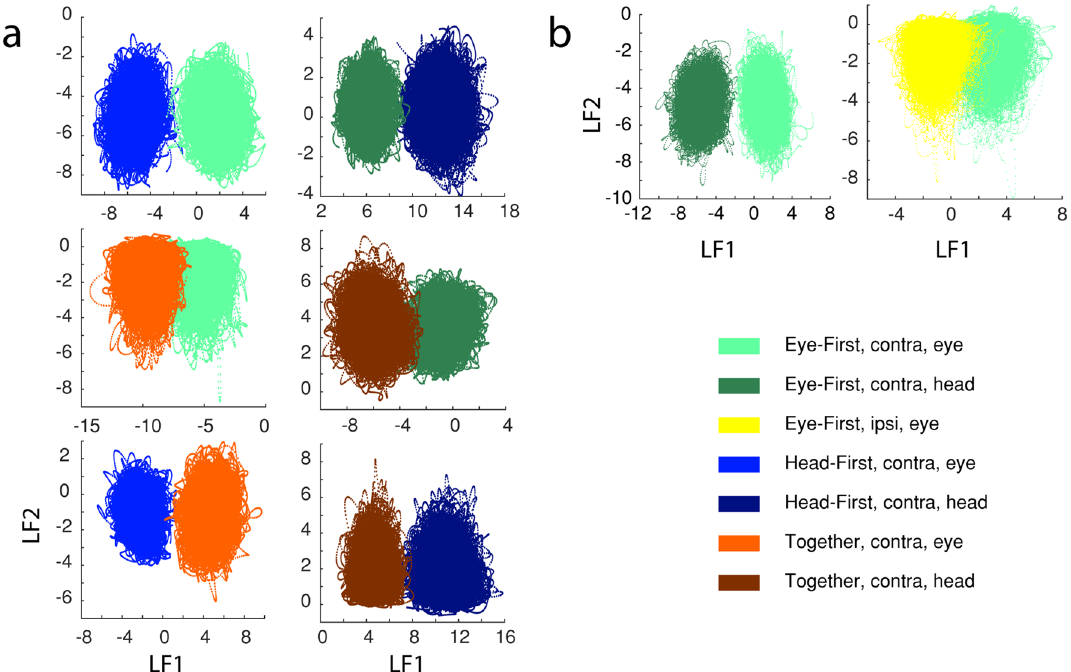
Figure 7. Representation of PMv pseudo-population activity using linear discriminant analysis. Each panel shows a phase plane plot of latent factor 1 (LF1) against latent factor 2 (LF2), with time implicitly represented in the trajectories. Each panel provides a pairwise comparison of two selected categories. ( A ) Comparisons of task-type conditions for contraversive eye movements (left column) and contraversive head movements (right column). LDA results show a difference in neural activity between head-first (blue), eye-first (green), and together (orange) trial types for eye (left column) and head (right column) movement epochs. The pairings and colors correspond to those found in Fig. 6B. ( B ) LDA results indicating separability of eye vs. head movement epochs (left) and ipsi- vs. contra-movements (right). The pairings and colors correspond to those shown in Fig. 6C,D.